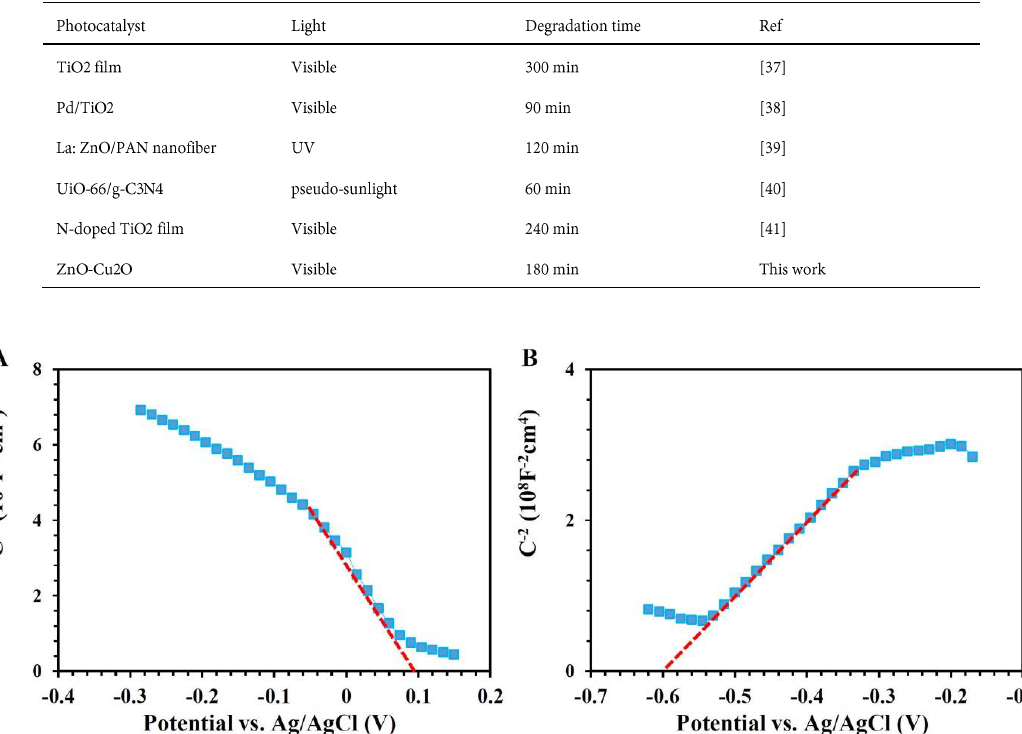
Comparison of the photocatalytic activity of the ZnO-Cu